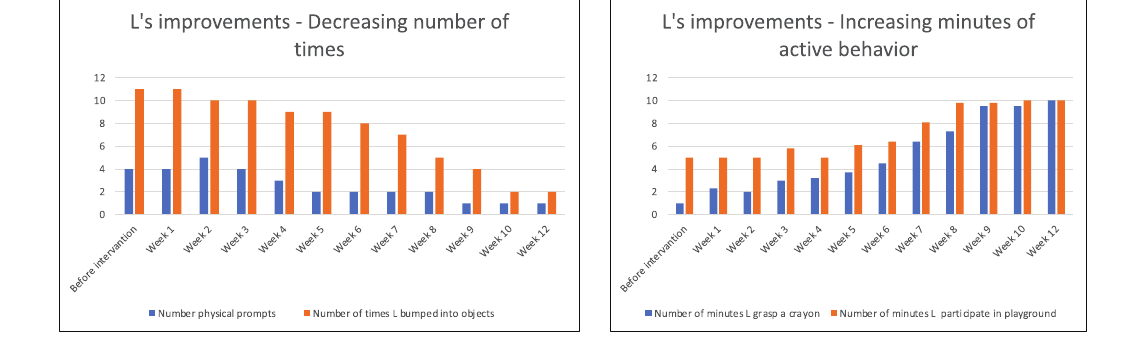
Figure 2. Weekly data collection sheets.